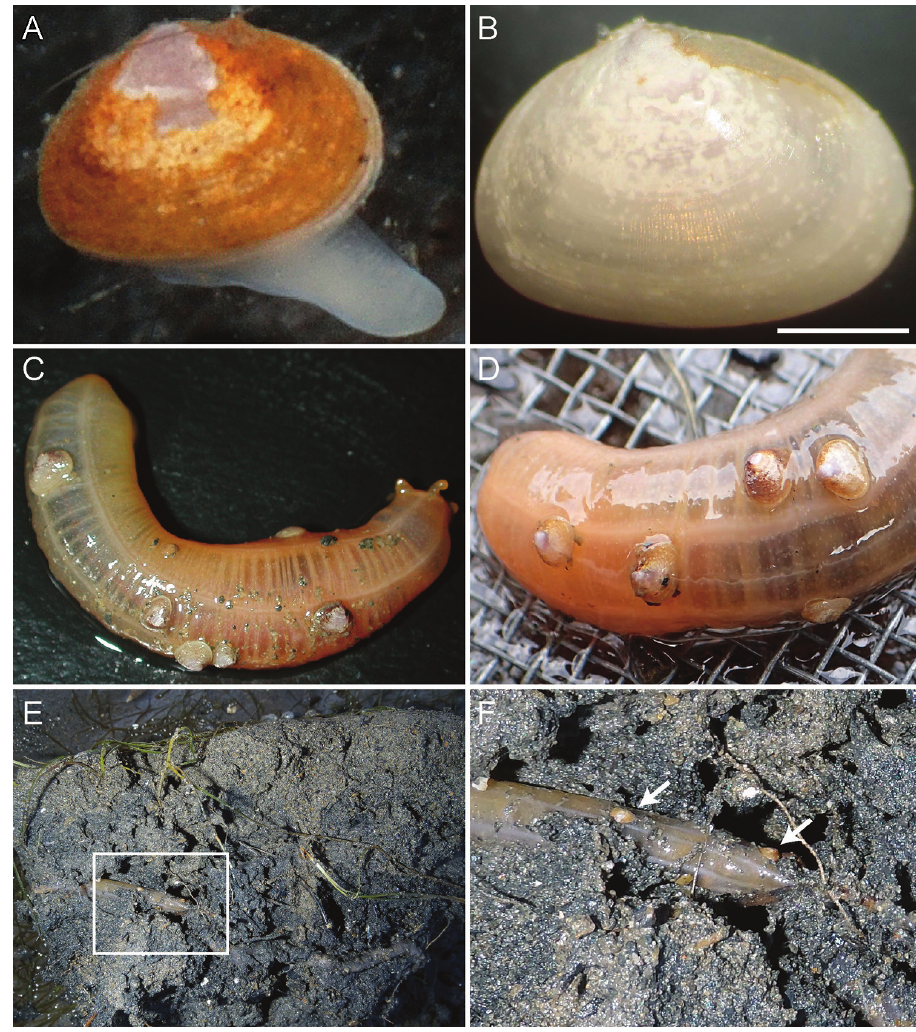
Figure 1. Borniopsis mortoni and its host. A A crawling individual of B. mortoni. B Right shell valve of Paratype 4 (NSMT Mo 78969) bleached to remove the periostracum for observation of shell surface sculpture C, D Patinapta ooplax with multiple individuals of B. mortoni attached E, F P. ooplax in situ in mud flats with B. mortoni attached (arrowed). Photo credits: H. Ishikawa: A–C, E, F ; Y. Hamamura: D . Scale bar: 1